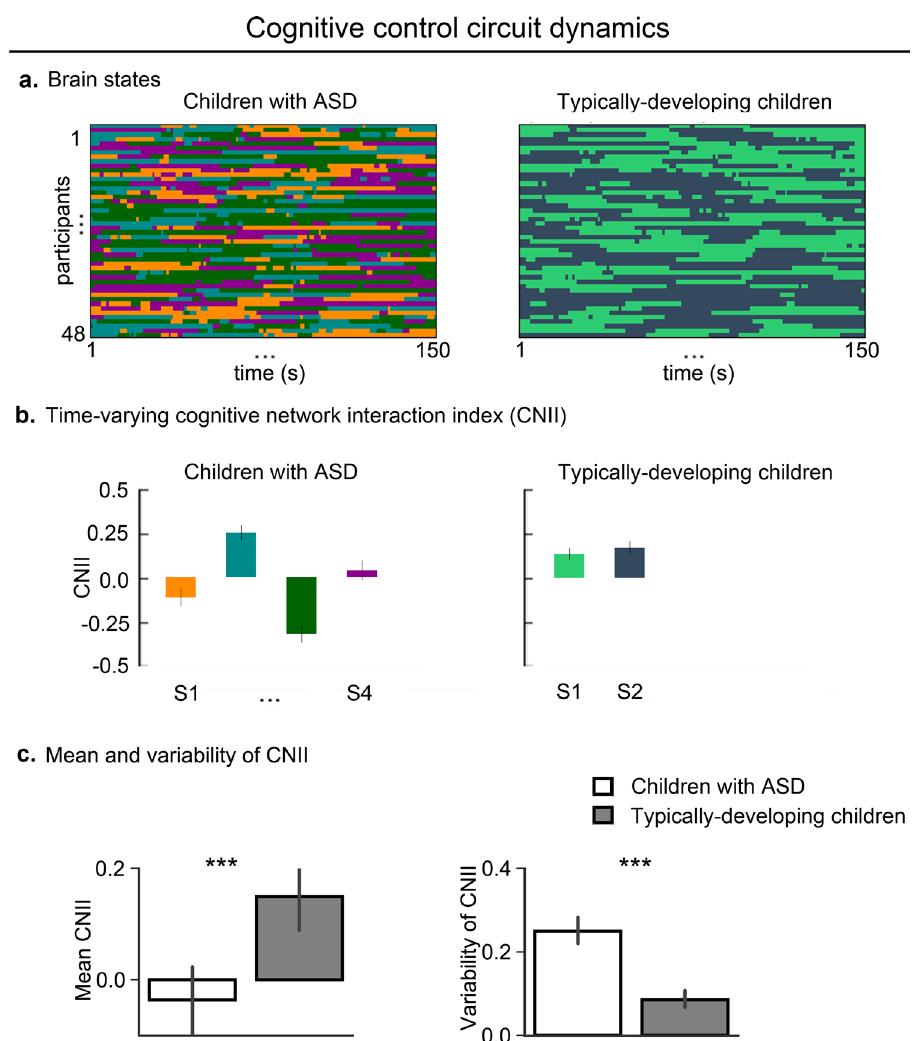
Fig. 2 Aberrant temporal dynamics of cognitive control circuit in children with ASD. a Children with ASD showed four states and TD children showed two states. Color codes distinct states in each participant. States 1, 2, 3, and 4 in children with ASD are represented by dark orange, dark cyan, dark green, and dark magenta, respectively; states 1 and 2 in TD children are represented by lime green and dark blue, respectively. b Cognitive NII (CNII) of dynamic brain states showed intermittently reduced cross-network interaction in children with ASD compared to TD children. c The temporal mean of dynamic cross-network interaction in the cognitive control circuit, assessed using mean of dynamic CNIIs across states, was signi fi cantly lower in children with ASD, compared to TD children. The temporal variability of dynamic cross-network interaction in the cognitive control circuit, assessed using standard deviation of dynamic CNIIs across states, was signi fi cantly higher in children with ASD, compared to TD children. Two-sided two sample t -tests were used to compare mean and temporal variability of CNIIs between children with ASD and TD children. Error bar shows standard error of mean. *** p <